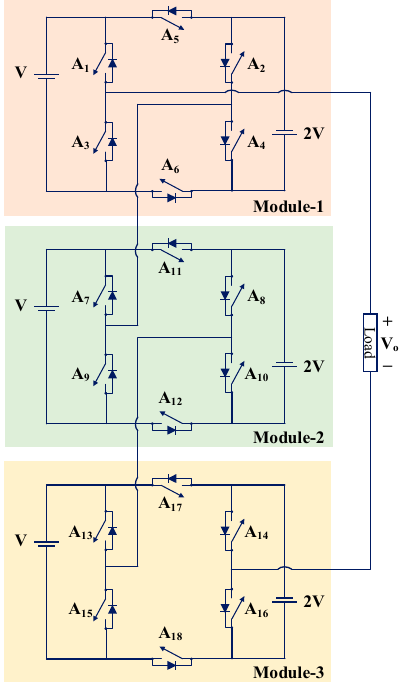
Figure 47. Single-phase thirteen-level FT MLI (TP52) [83].